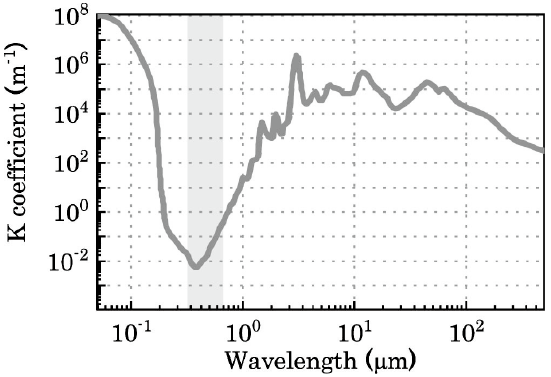
Figure 1. Underwater attenuation at different wavelengths.